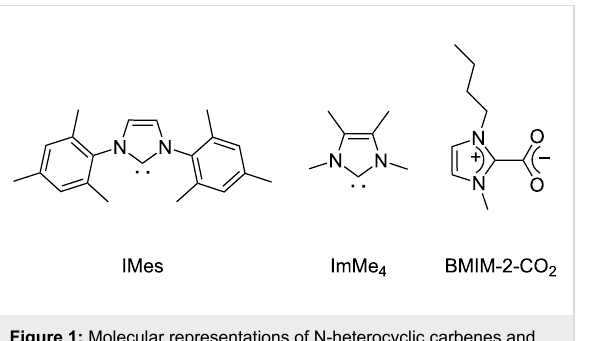
Figure 1: Molecular representations of N-heterocyclic carbenes and BMIM-2-CO 2 .